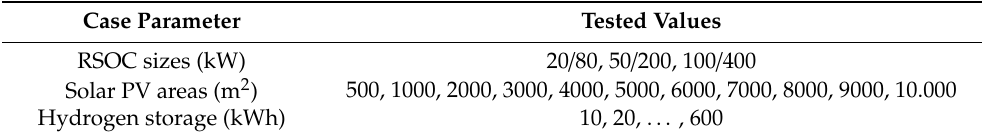
Table 3. Tested case